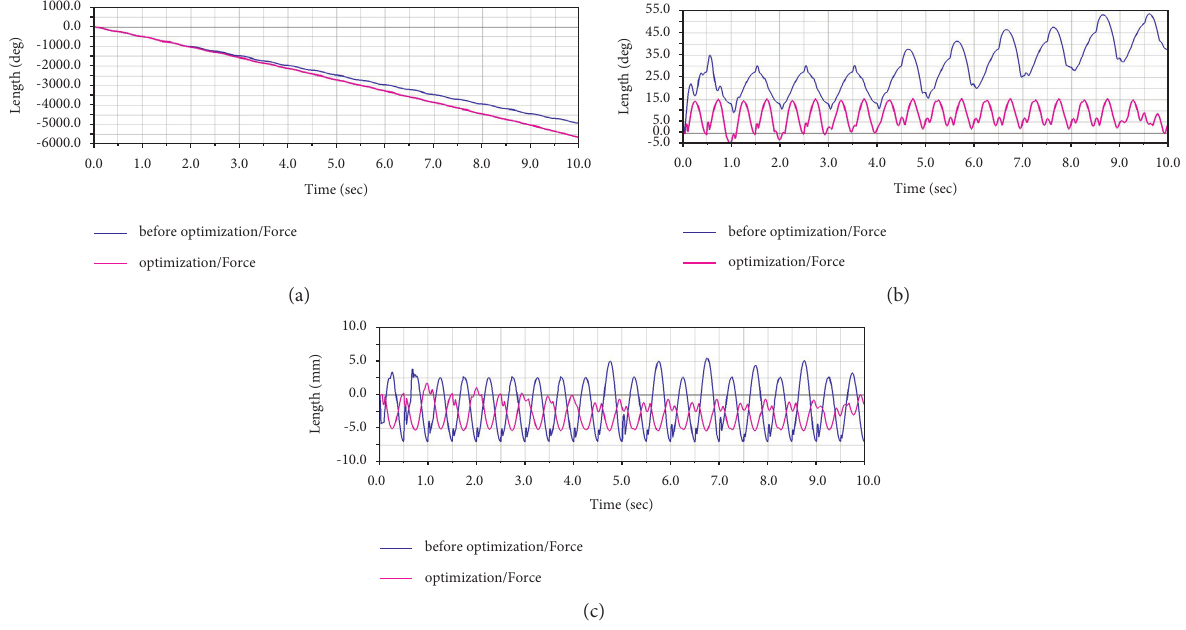
Figure 8: Body CoM displacement curve. (a) Forward curve; (b) lateral curve; (c) vertical